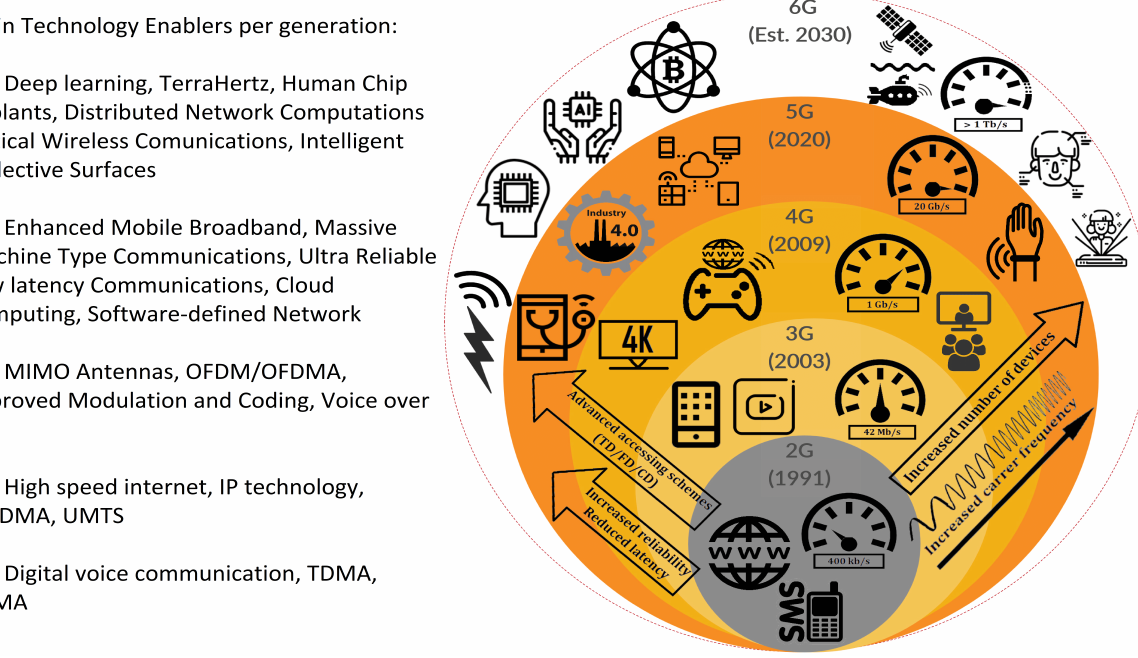
Figure 1. A brief overview of the history of wireless communication networks (TD: time division, FD: frequency division, CD: code